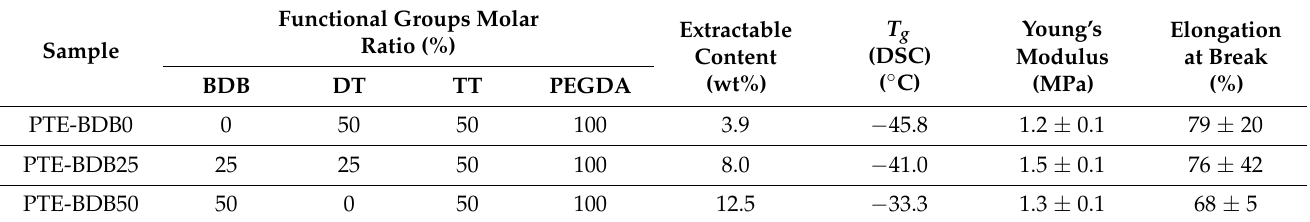
Table 1. Compositions and characterizations of PTE-BDB